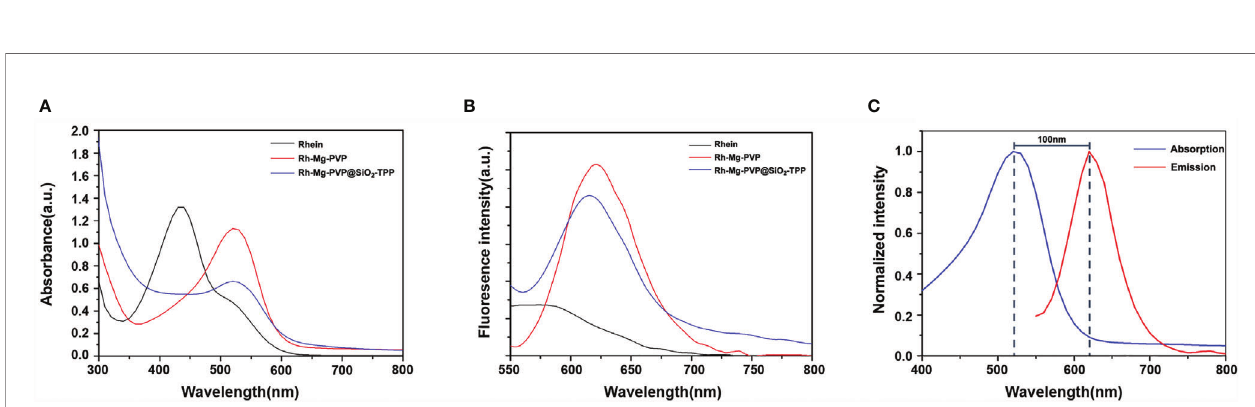
FIGURE 2 | (A) UV – vis absorption spectra and (B) fl uorescence emission spectra of rhein, Rh-Mg-PVP, and Rh-Mg-PVP@SiO 2 -TPP NPs. (C) Absorption and emission spectra (normalization) of Rh-Mg-PVP@SiO 2 -TPP NPs ( l ex = 520